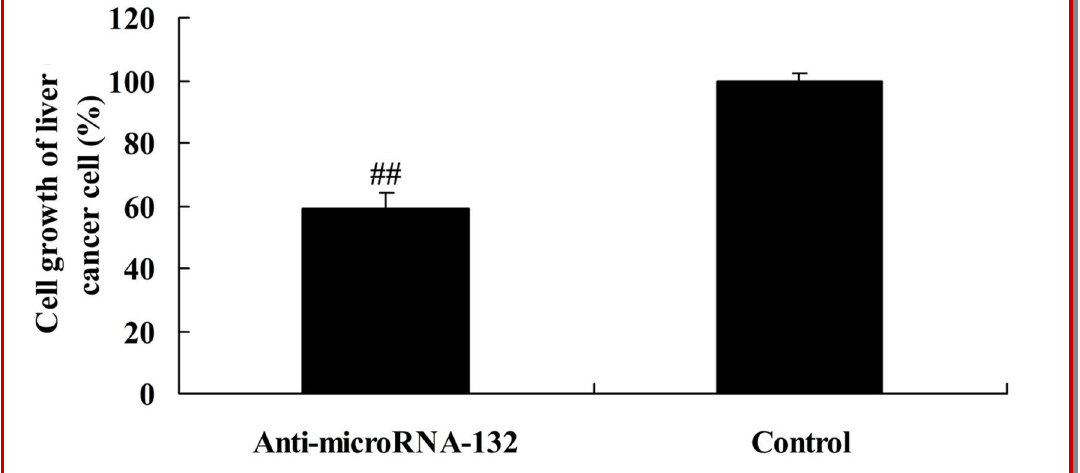
Figure 2: Mediation of microRNA-132 on cell growth of liver cancer cell; ## p<0.01 compared with normal